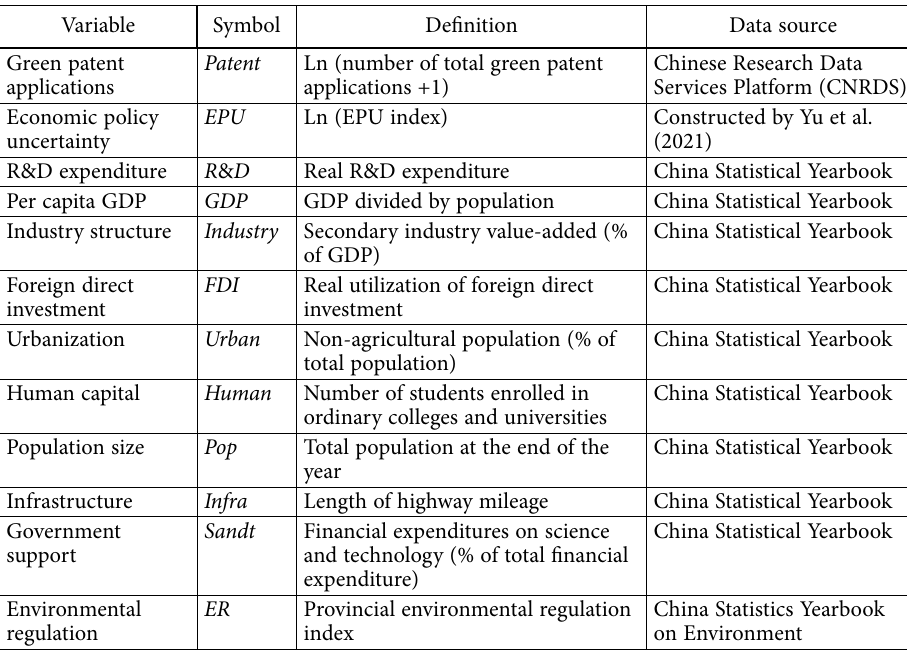
Table 1. Variable definitions and data sources